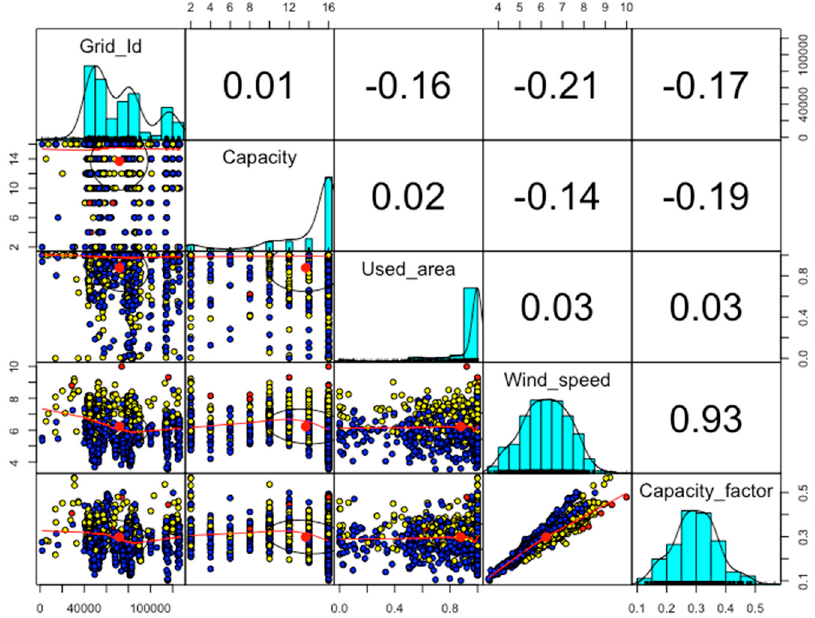
Figure 2. Nonlinear and highly correlated hourly wind turbine data.